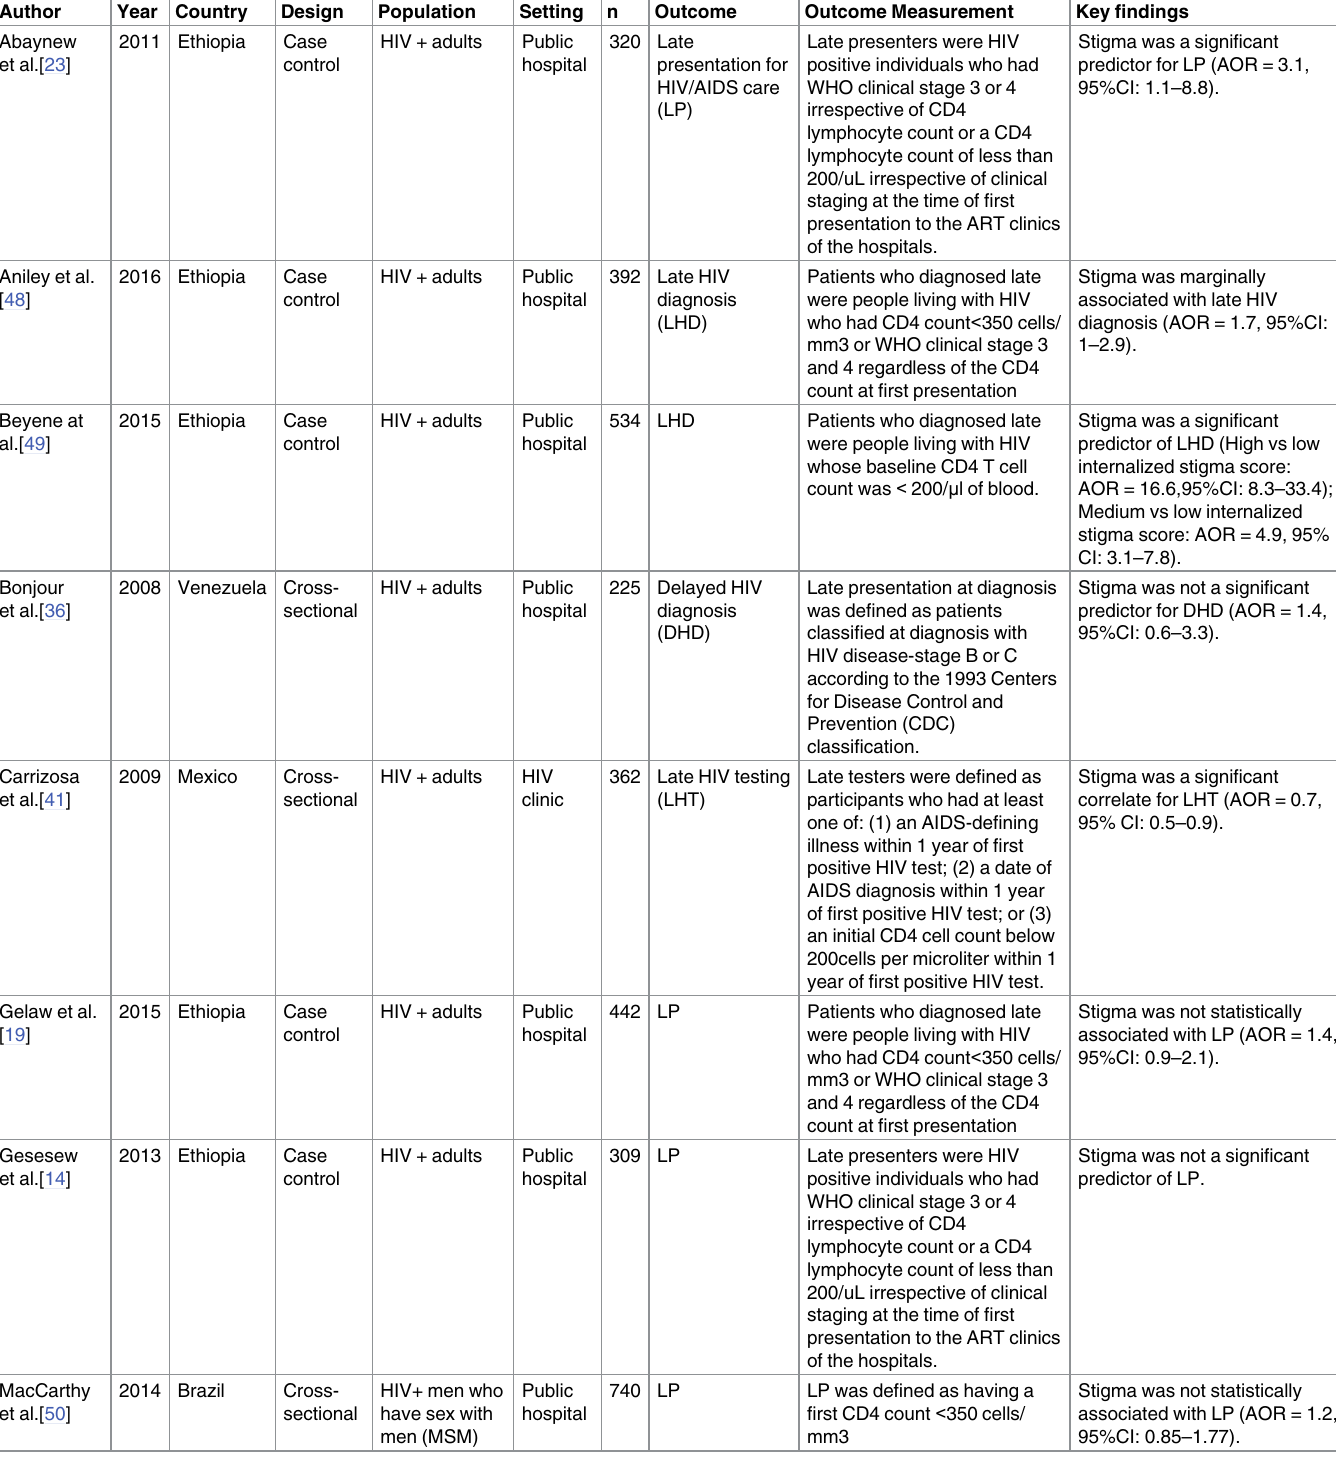
Table 1. Characteristics of included articles (n =